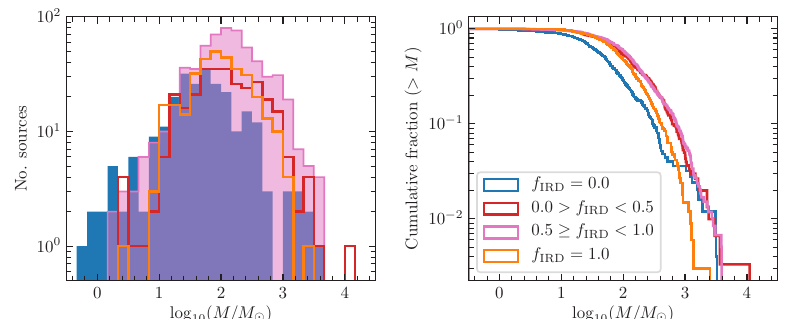
Figure 3. GASTON 1.2 mm compact source mass distributions as a function of their infrared darkness Figure 2. GASTON 1.2 mm compact source flux (left) and mass (right) distributions. The blue his- parameter. The histograms show the mass distributions of sources with: i) f IRD = 1 (i.e. completely togram shows all GASTON sources identified. The red histogram shows GASTON sources that are infrared-dark) in orange; ii) 1 > f IRD > 0 . 5 in pink; iii) 0 . 5 > f IRD > 0 in blue and iv) f IRD = 0 (i.e. not associated with a band merged (BM) Herschel clump [16]. The orange histogram shows GAS- completely infrared-bright) in blue. The di ff erential distributions are displayed on the left-hand-side TON sources that are not associated with a Herschel 250 µ m sources from [14] Hi-GAL catalogue. The panel, the cumulative forms are displayed in the right-hand-side vertical dashed line on the left panel shows the 3 σ 1 . 2 mm detection threshold for beam-size sources. cirrus noise. This sample of previously undetected sources opens up a brand new window on the characterisation of the earliest stages of star formation.